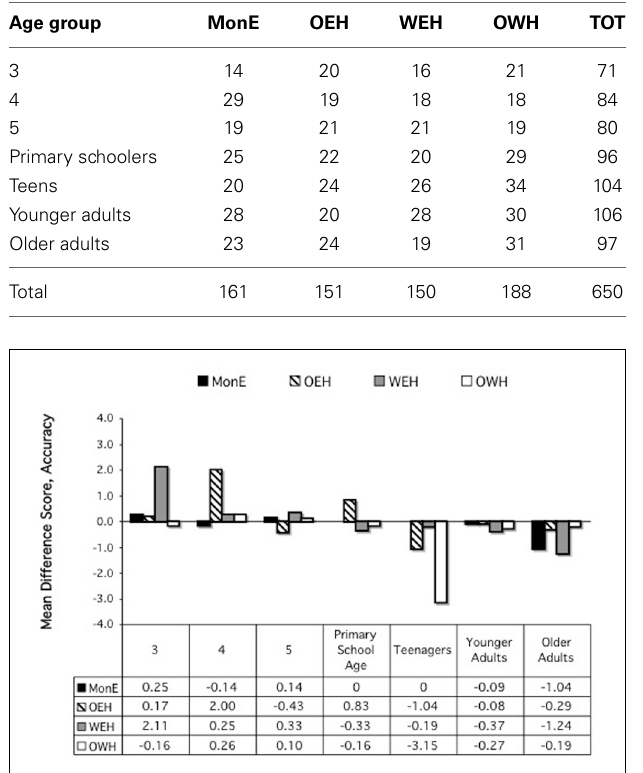
FIGURE 2 | Differences scores, reaction times, on card sort tasks, by age and home